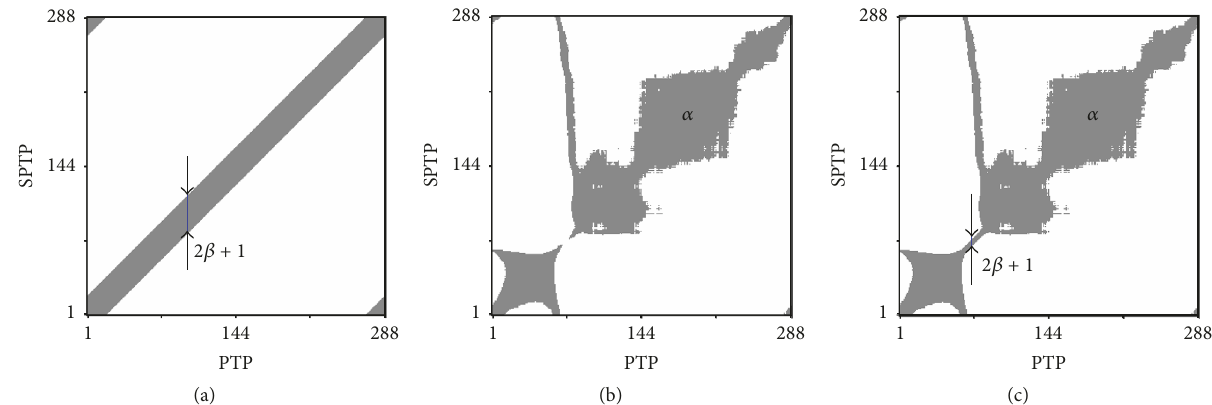
Figure 1: Static data segments used for forecasting. (a) KNN-D, (b) KNN-U, and (c) KNN-UD. Note: gray area is used segment, PTP (prediction time point, 5 min), and SPTP (selected past time point, 5 min).